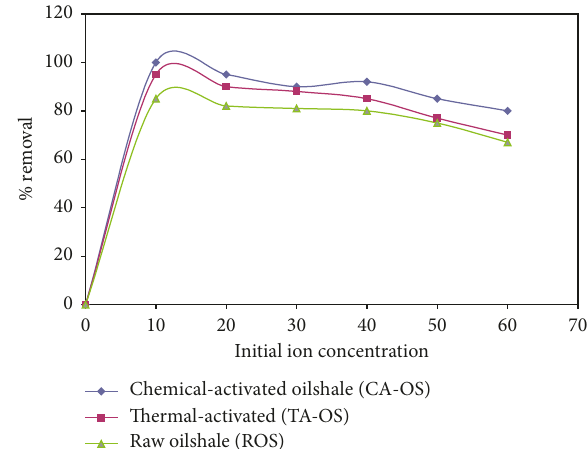
Figure 4: Comparing the effect of initial ion concentration on the percentage removal of Zn.